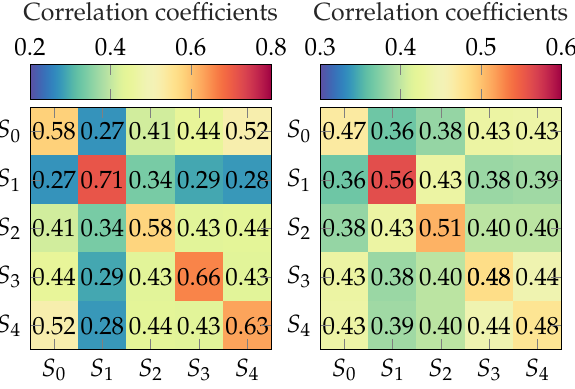
Figure 10. Maximum correlation coefficients of the cross-correlation for the gearbox with damage to gear z 1 ( left ) and for the gearbox with damange to z 3 ( right ) averaged over equal damage